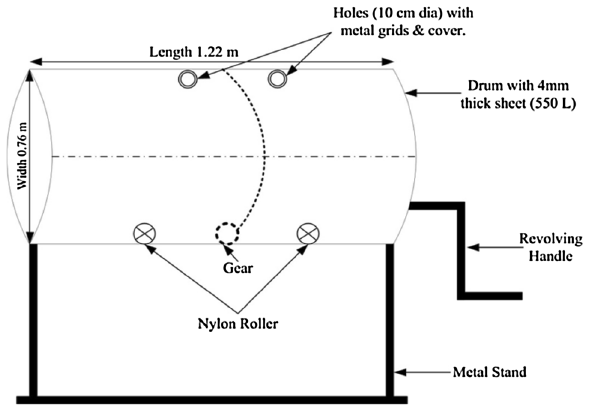
Fig. 1 Pilot-scale rotary drum composter schematic